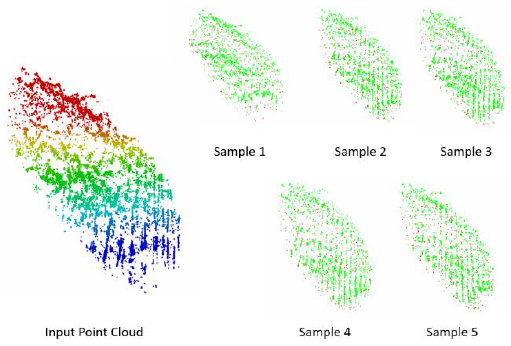
Figure 2. Result of T-Sampling algorithm (red: base points; green: additional points).